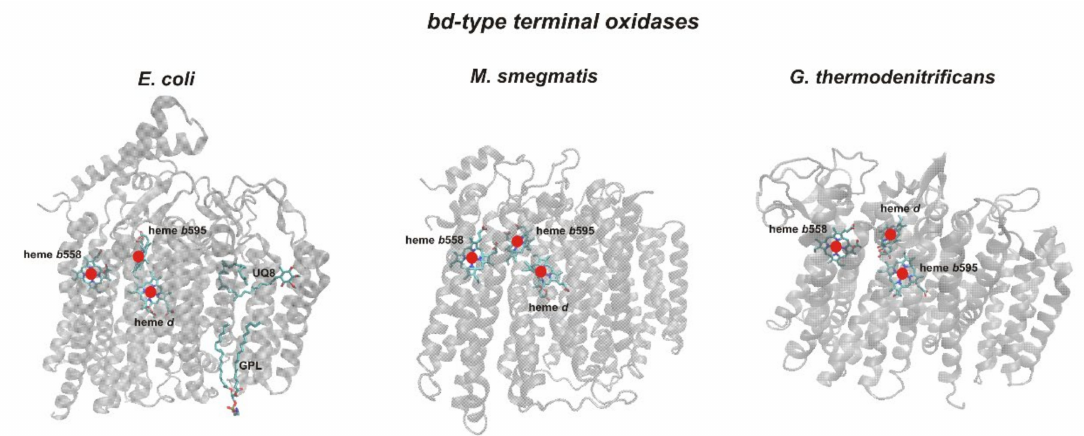
Figure 2. Overall structures of bd -type oxidases from E. coli ([35], PDB ID: 6RX4), M. smegmatis ([81], PDB ID: 7D5I), and G. thermodenitrificans K1041 ([33], PDB ID: 5DOQ). The three hemes in all structures are in a triangular arrangement but positions of heme b 595 and heme d in the enzymes from E. coli and M. smegmatis are interchanged as compared to those in the G. thermodenitrificans oxidase. The figure was carried out using Visual Molecular Dynamics software (v1.9.3)